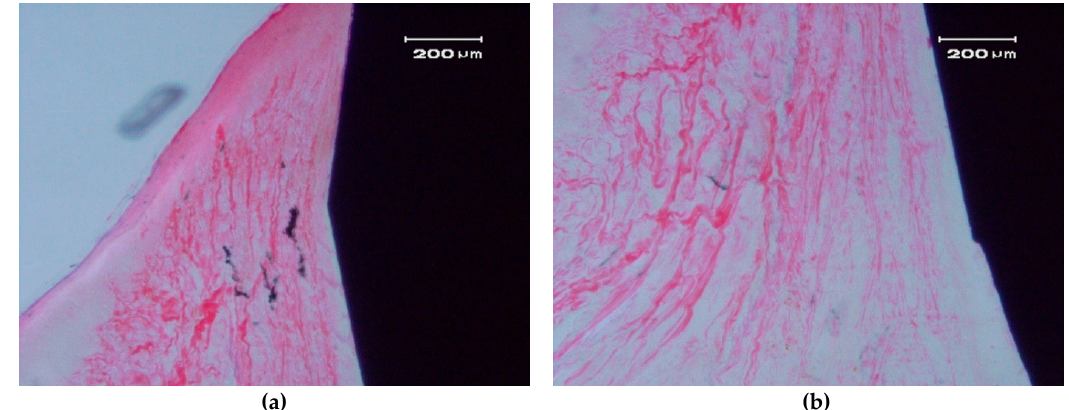
Figure 6. Bone apposition on the surface of a ZCe-A implant after eight weeks of healing (longitudinal cross-section). The bone in contact with the implant shows a lamellar and Haversian structure. ( a ) left side and ( b ) right side of the implant In the hard tissue area, a direct and close apposition of the bone matrix to the implant surface is observed, without the presence of a non-mineralized connective tissue interface.